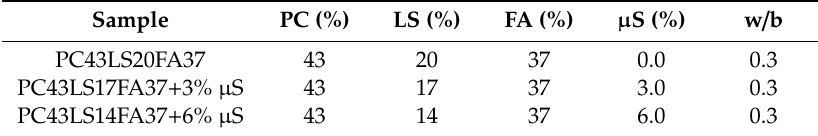
Table 3. Quaternary µ S enhanced cement paste formulations—low PC—Mix Proportions % by total mass of